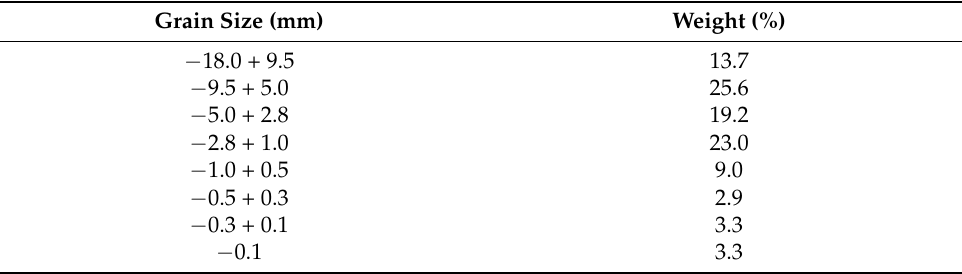
Table 2. Particle size analysis of the ore.